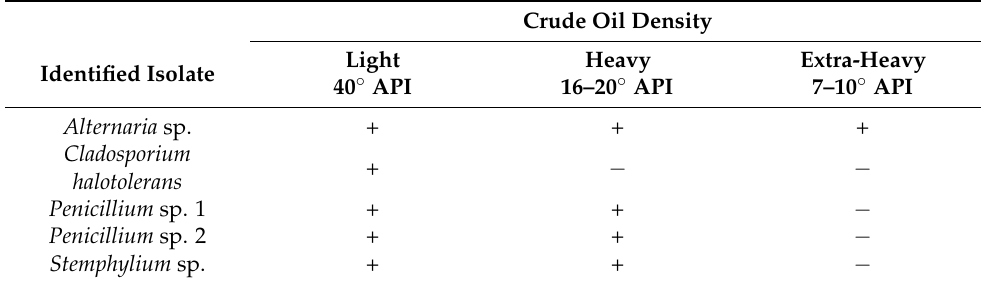
Table 1. Growth of selected fungi in crude oils of different densities. The culture was carried out in 50 mL of modified Czapek minimal medium with 0.5% w/v of crude oil as the sole carbon source. Crude Oil Density Light Identified Isolate